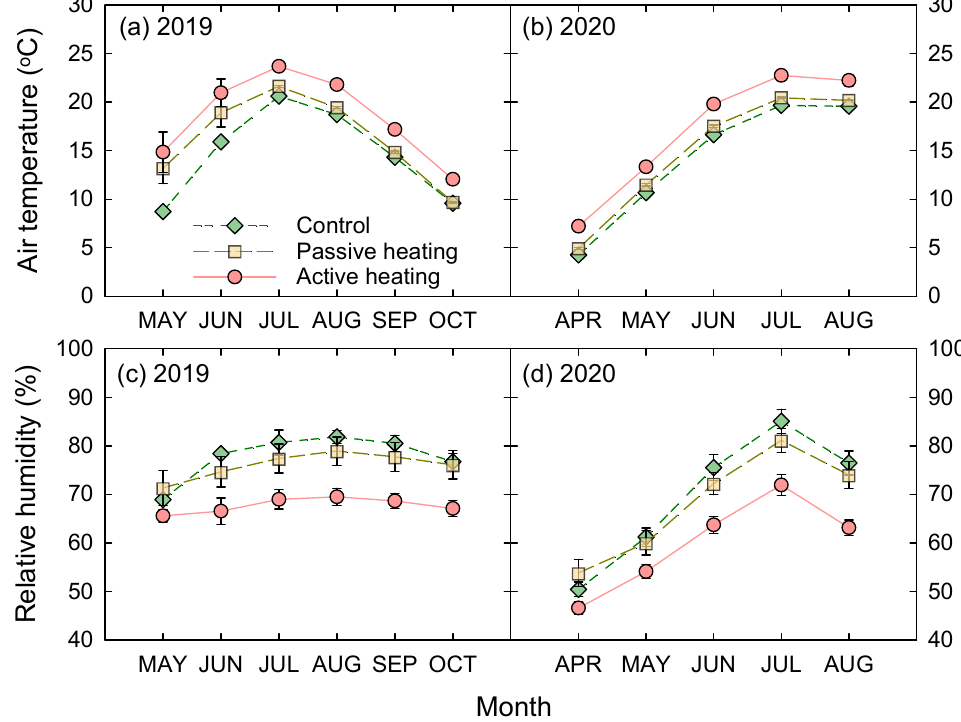
Figure 3. Mean monthly atmospheric temperatures in 2019 ( a ) and 2020 ( b ), as well as mean relative humidity in 2019 ( c ) and 2020 ( d ) of different treatments. Green diamonds denote the ambient control plots (CON), yellow squares are passive-heating (PH) open-top-chambers (OTCs), while red circulars indicate the and active-heating (AH) OTCs. The values are means ± SEs (four weather stations in the AH and PH chambers and two weather stations in the CON).